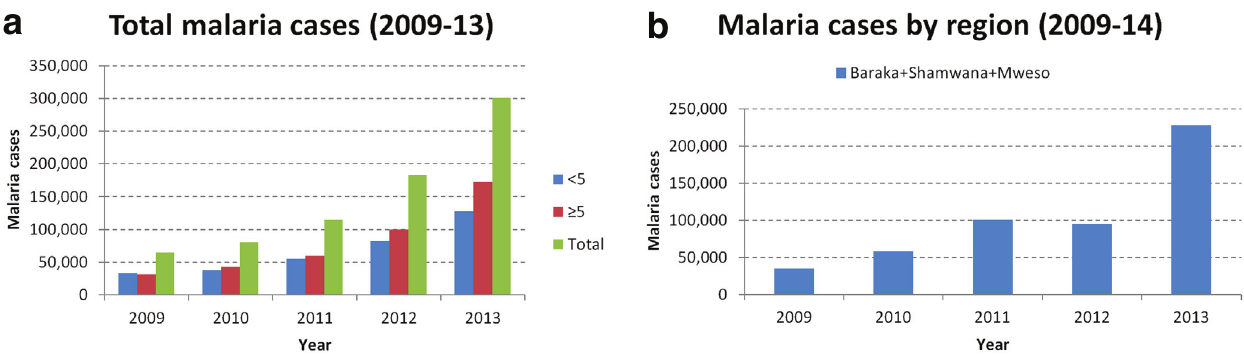
Figure 1. Confirmed malaria cases in MSF-OCA programmes and in fixed programmes in Baraka, Shamwana and Mweso in 2009–2011.